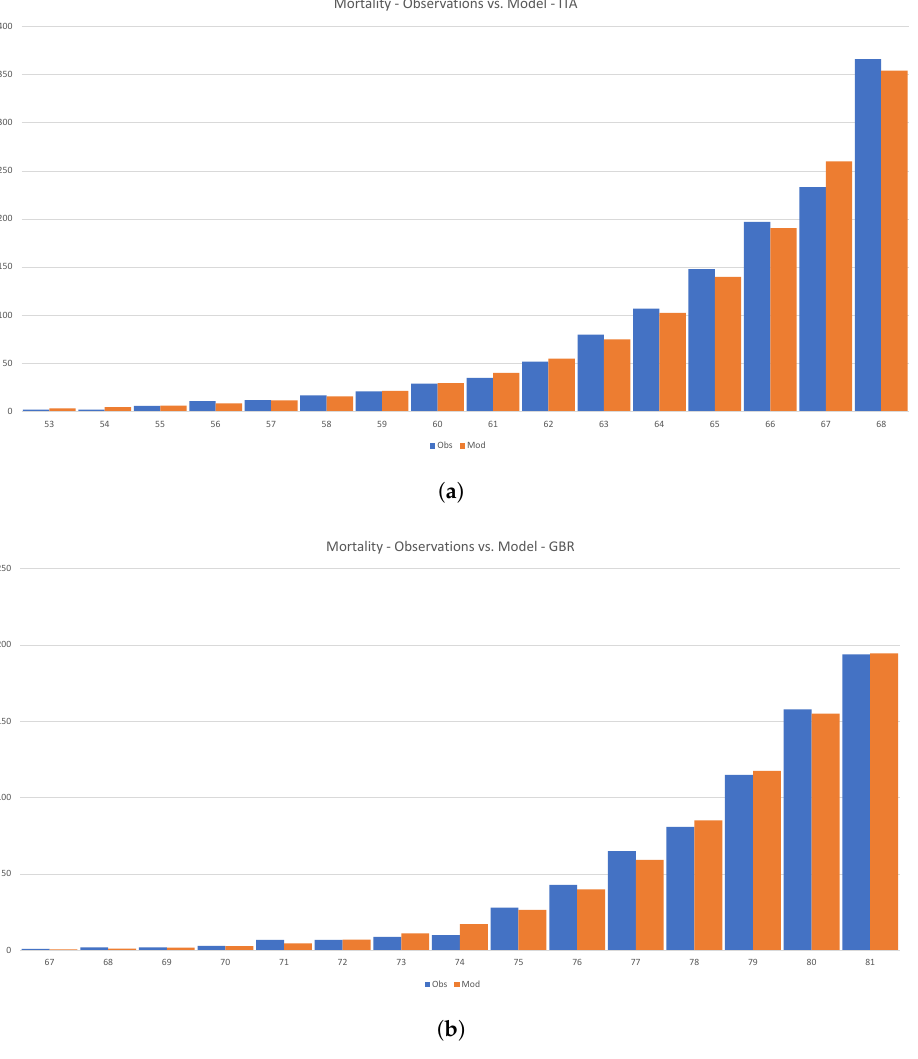
Figure 17. Calibration of the SIR model to the initial phase of the disease in Italy and the U.K. ( a ) Mortallity-Observations vs. Model—ITA ( b ) Mortallity-Observations vs.